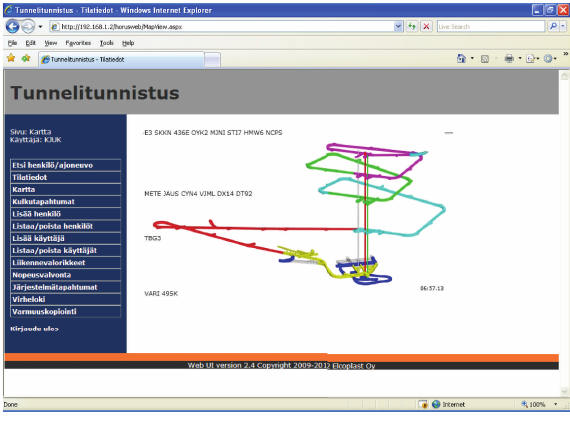
Figure 15: An example map